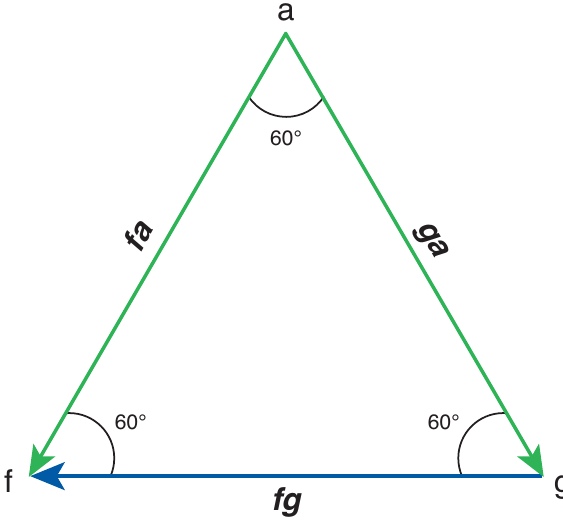
Fig. 4. Relationship between forecasts and analysis in the case of lack of predictive skill and mutual